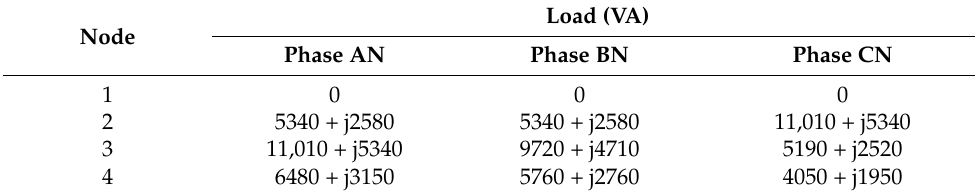
Figure B1. Configuration of the 4-node LVDS. Table B1. Load of each node.